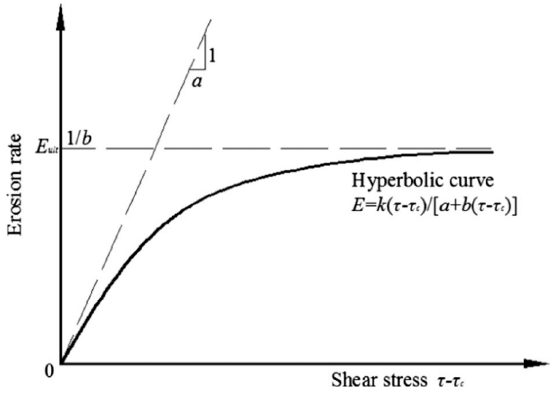
Figure 2. The hyperbolic curve of soil erosion rate.